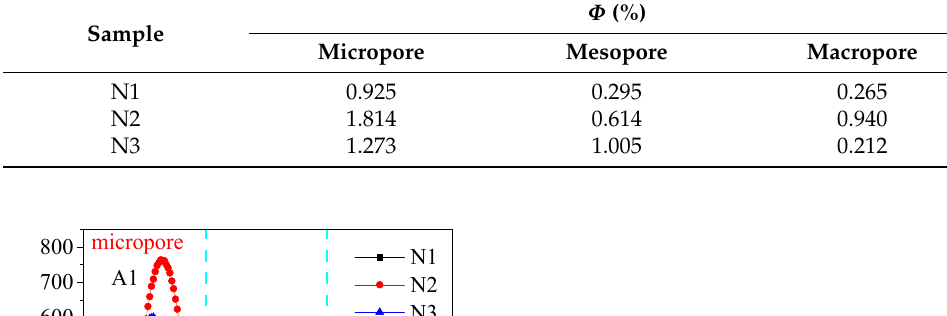
Table 2. Results of NMR experiment.